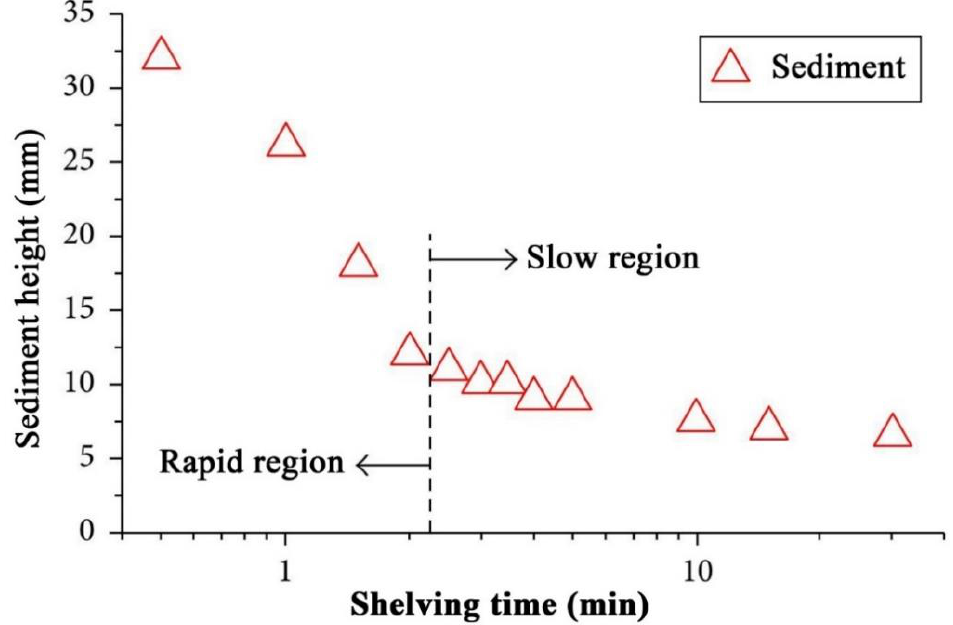
Figure 13. A demonstration of the two sedimentation regions in terms of settling speed, where (the left side) shows the rapid region in which the sediment height changes rapidly, and (the right side) illustrates the slow region, where the changes in the sediment height are very slow to the point where it can be negligible [13].